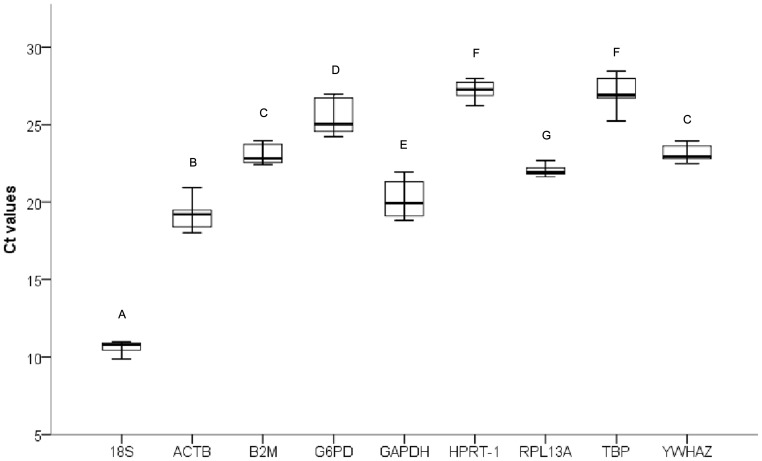
Distribution of qRT-PCR quantification cycle values for the candidate RGs.Box plot graphs of Ct values for each RG tested in all samples. Vertical lines indicate range of values, and the median Ct value is represented as black horizontal line within the box plot. The box indicates the 25th and 75th percentiles. Letters indicate a significant difference in average Ct value. Average Ct values that have the same letter are not significantly different (P>0.05).